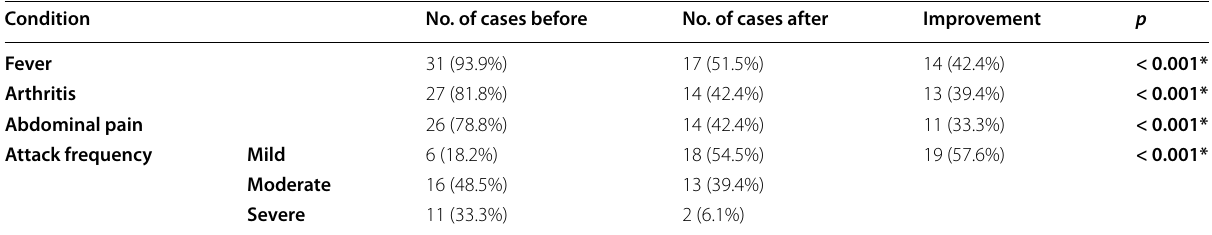
Total 33. Attack frequency: Mild (1/month), Moderate (2/month), Severe ( =